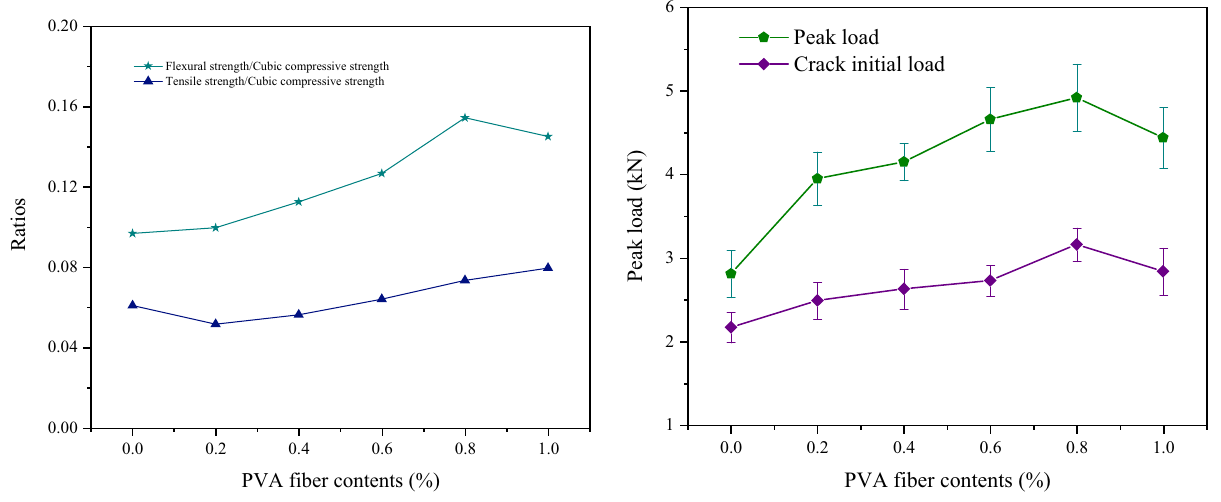
Figure 18: Ratios versus PVA fi ber contents.